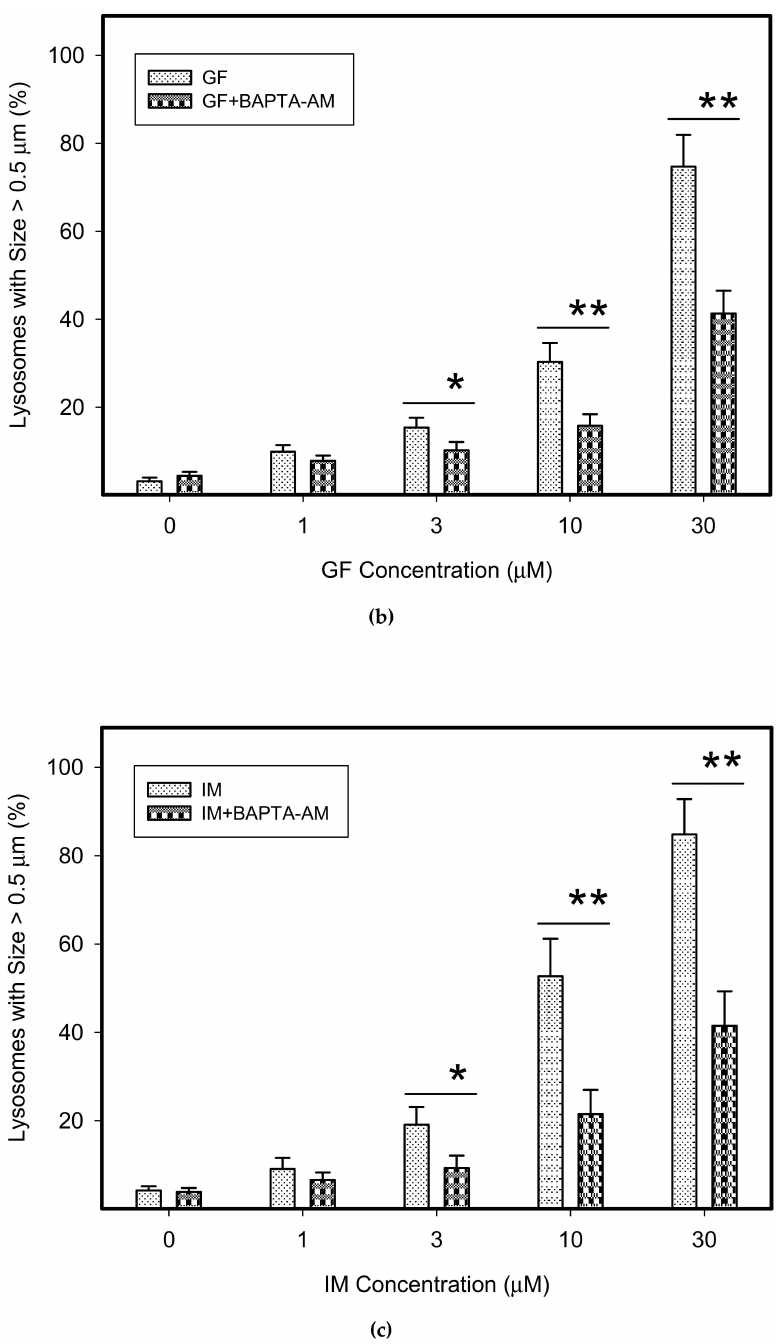
Figure 10. E ff ect of calcium chelator, BABTA-AM, on lysosomal morphology in HL-60 cells treated with TKIs. Cells were cultured for 6 h in the presence of particular TKI with or without 10 M BAPTA-AM under standard conditions and then fixed in paraformaldehyde and subjected to the immunostaining of LAMP1. Cells cultured in medium without TKIs were taken as a control. ( a ) Morphologic changes in lysosomes of HL-60 cells (typical analysis). ( b ) Quantitative analysis of lysosomal size in GF treated HL-60 cells. ( c ) Quantitative analysis of lysosomal size in IM treated HL-60 cells. Lysosomal morphology was evaluated in at least 250 cells for each treatment. The results are shown as means of four independent experiments with standard deviations. * denotes significant change in the number of lysosomes with size > 0.5 µ m ( p < 0.05) between cells treated with TKI and cells treated with TKI + BAPTA-AM. ** denotes significant change in the number of lysosomes with size > 0.5 µ m ( p < 0.01) between cells treated with TKI and cells treated with TKI +